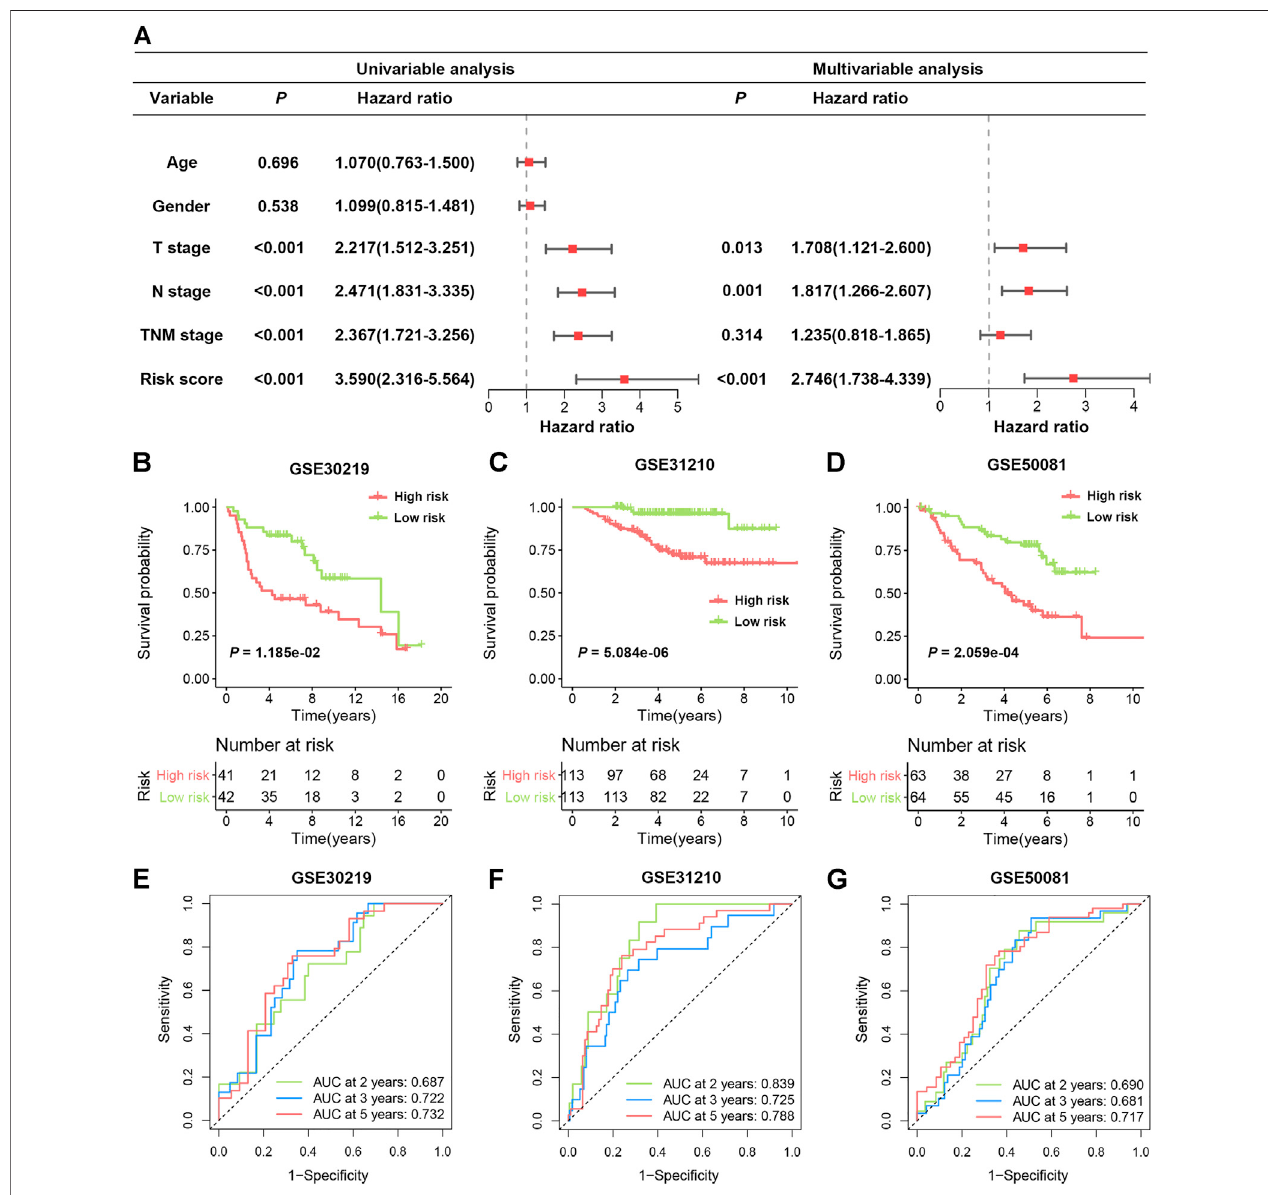
FIGURE 4 | Validation of SRS in independent cohorts. (A) . Univariable and multivariable Cox regression analysis of SRS and overall survival in the TCGA cohort. (B – D) : Kaplan-Meier curves of OS in high- and low-risk groups in the GSE30219, GSE31210, and GSE50081 datasets. (E – G) : ROC curve analyses in the GSE30219, GSE31210, and GSE50081